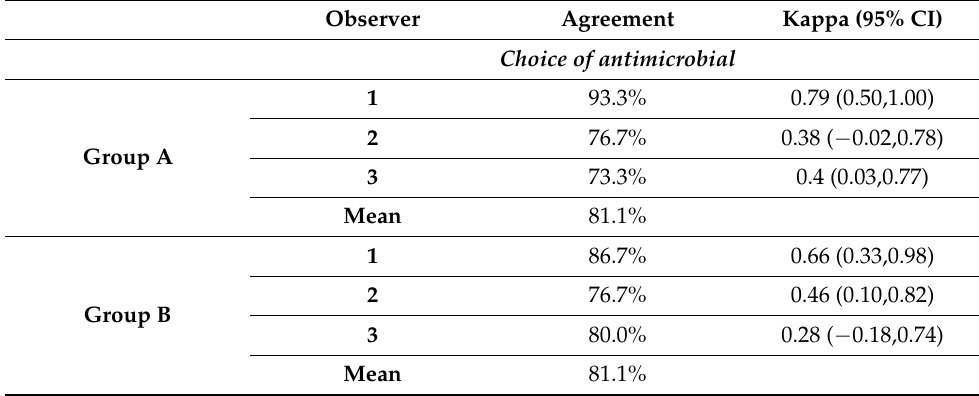
Table 1. Percentage of agreement and kappa (95% CI) of each observer with